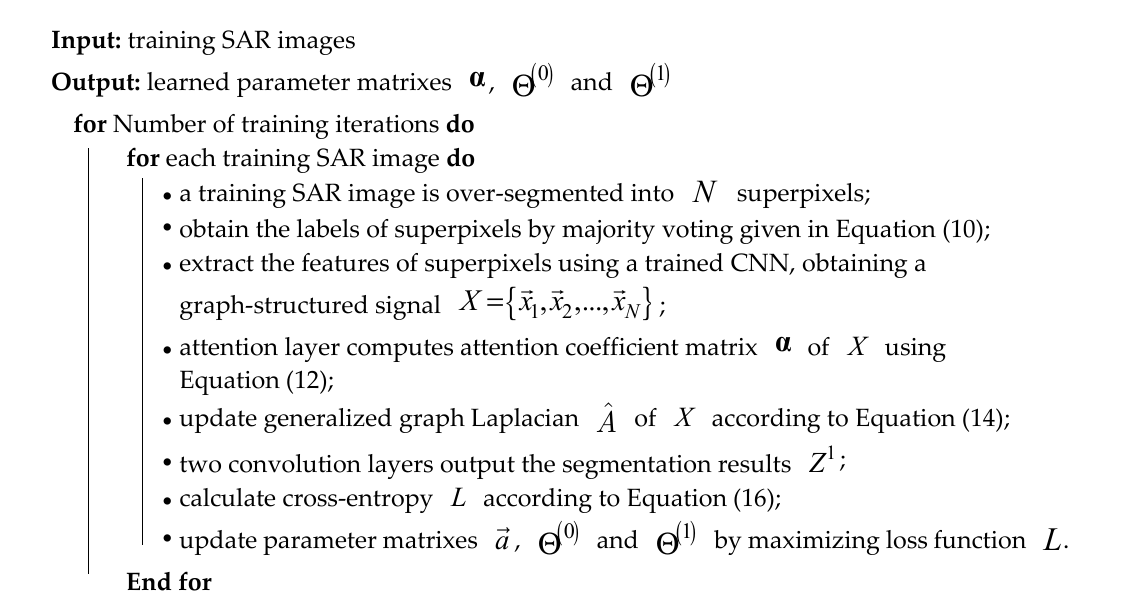
Algorithm 1 : Training AGCN for Image Segmentation.